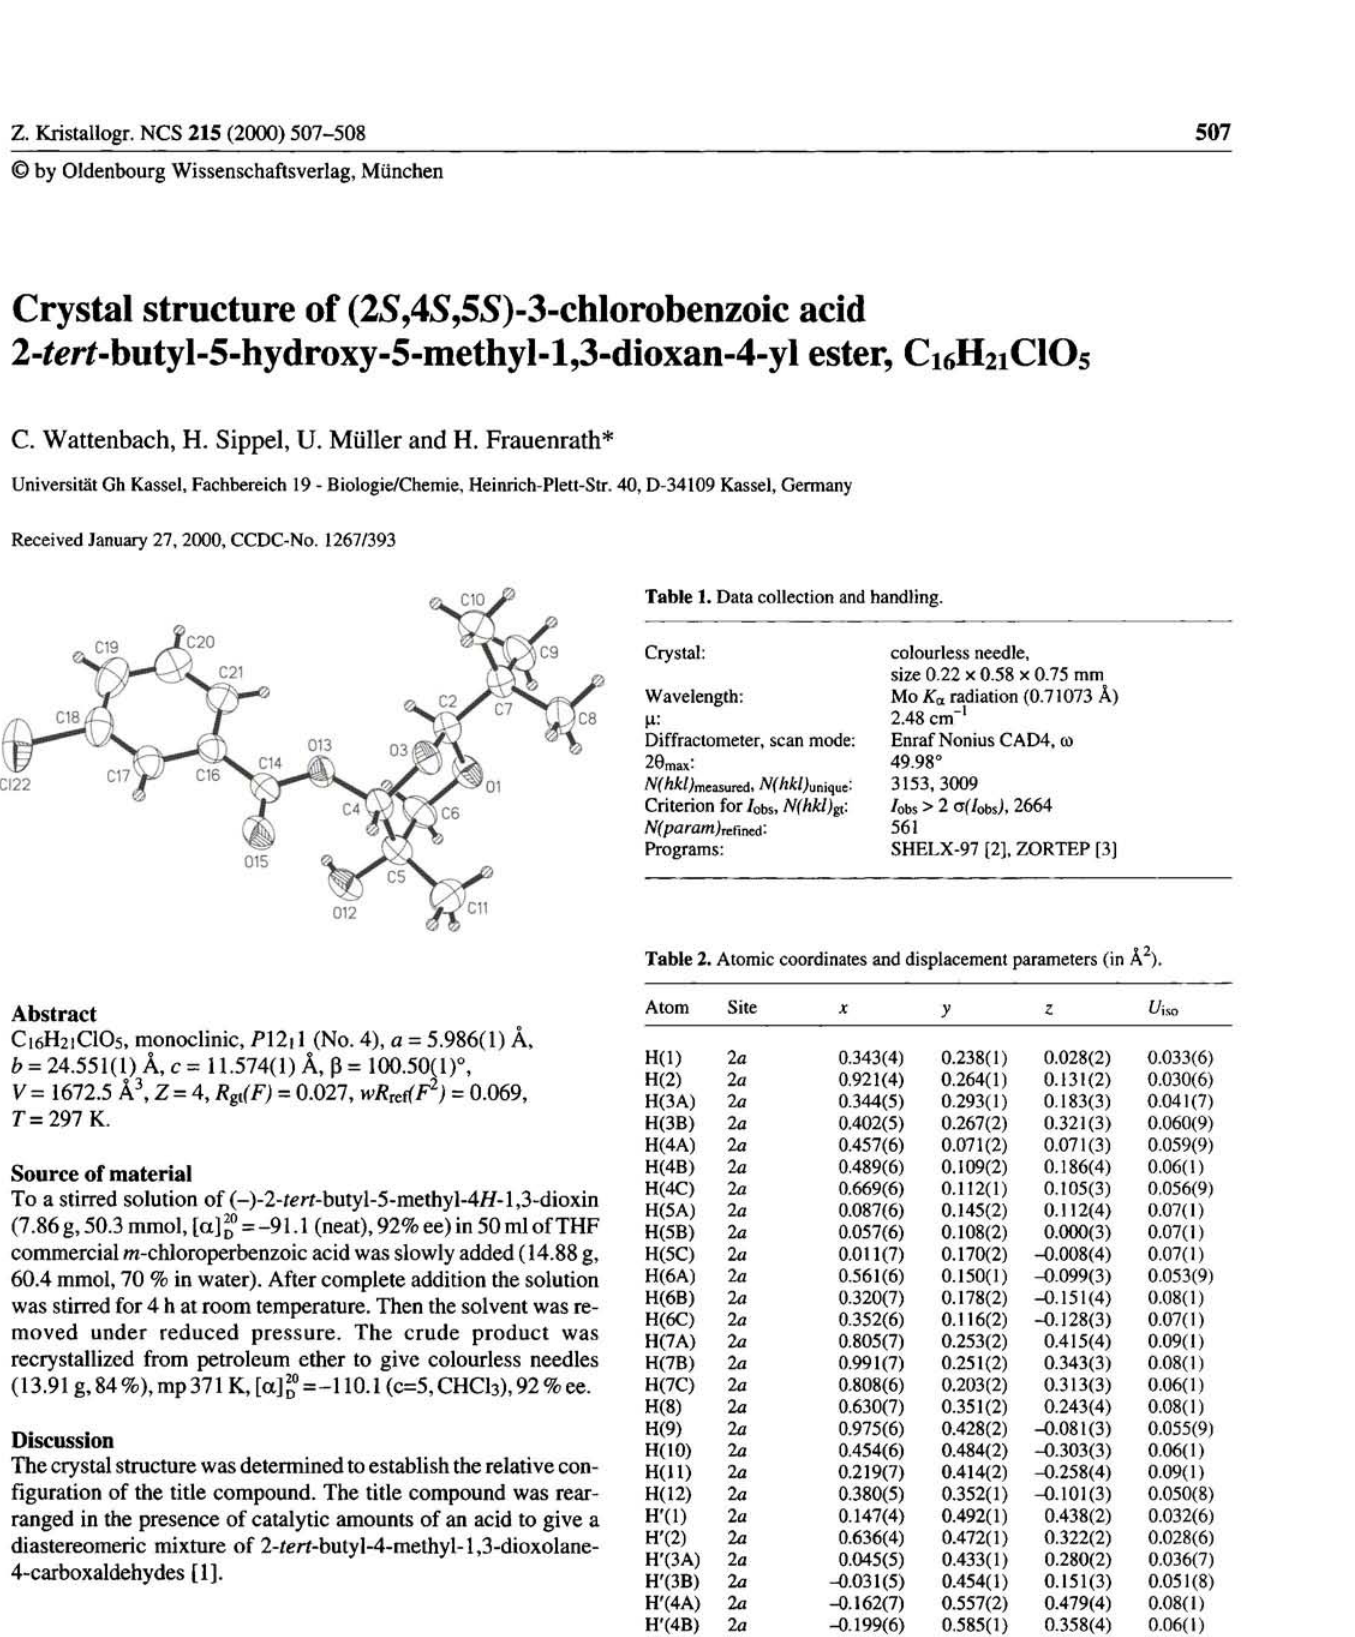
Table 2. Atomic coordinates and displacement parameters (in À